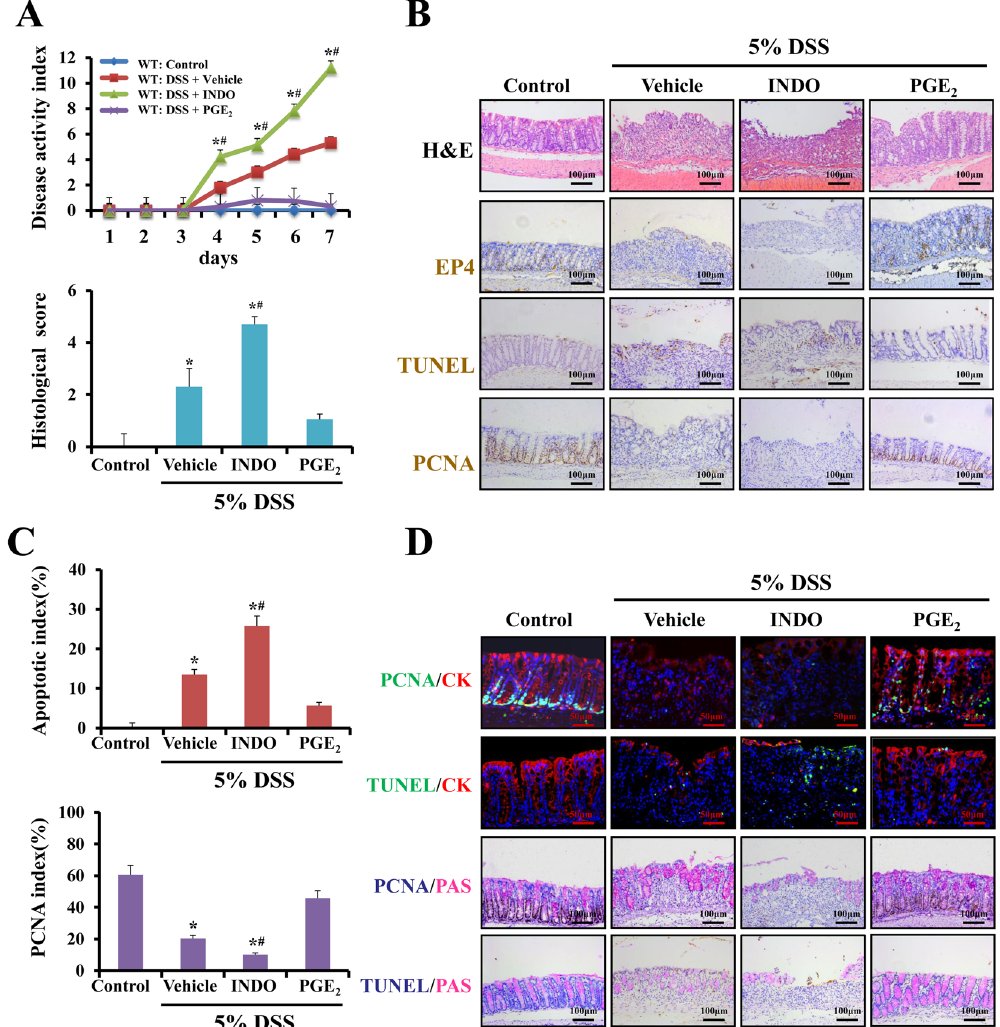
Figure 2. PGE 2 /EP4 alleviates mucosal injury in colitis. ( A ) The disease activity index was determined at the indicated time points as described in the Methods. Histological damage after DSS treatment for 7 days was scored after H&E staining as described in the Methods. * P < 0.05 compared with control group mice. # P < 0.05 versus vehicle group (n = 4 in each group). ( B ) Representative photomicrographs of H&E staining, TUNEL staining (brown, × 200), immunostaining of EP4 (brown, × 200) and PCNA (brown, × 200) in colonic sections of WT littermates in the indicated group. (n = 4 in each group). ( C ) The apoptotic index was measured by quantifying TUNEL signals in 100 random fields per section. The percentage of PCNA-positive cells is represented graphically. Values are expressed as the mean ± SD. n = 6 in each group, * P < 0.05 versus control mice, # P < 0.05 versus vehicle group. ( D ) Double stain for PAS and PCNA and PAS and TUNEL in four groups. PAS for goblet cells is pink ( × 200). Immunostaining of PCNA and TUNEL are shown in brown. Double immunofluorescence stain for cytokeratin and PCNA, cytokeratin and TUNEL in the indicated group ( × 400). Nuclei are stained with DAPI in blue. Localization of PCNA and TUNEL are visualized in green and cytokeratin is stained in red. The merging positive signals of PCNA or TUNEL and cytokeratin are visualized in yellow. (n = 4 in each